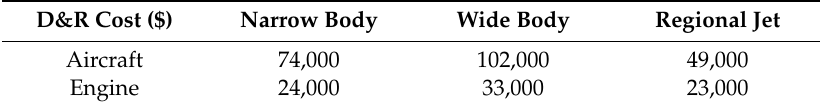
Table 2. Average dismantling cost of an aircraft / engine (2014 USD) [2].